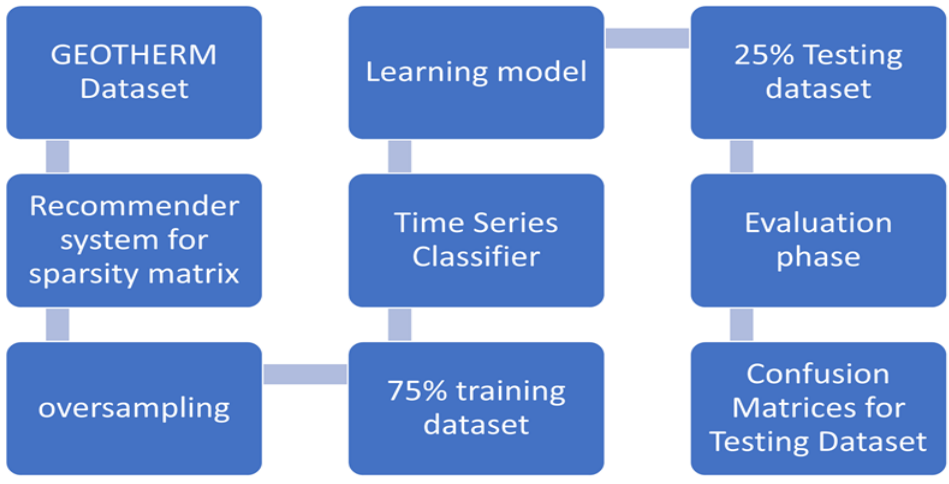
Figure 4. The architecture of the proposed model.